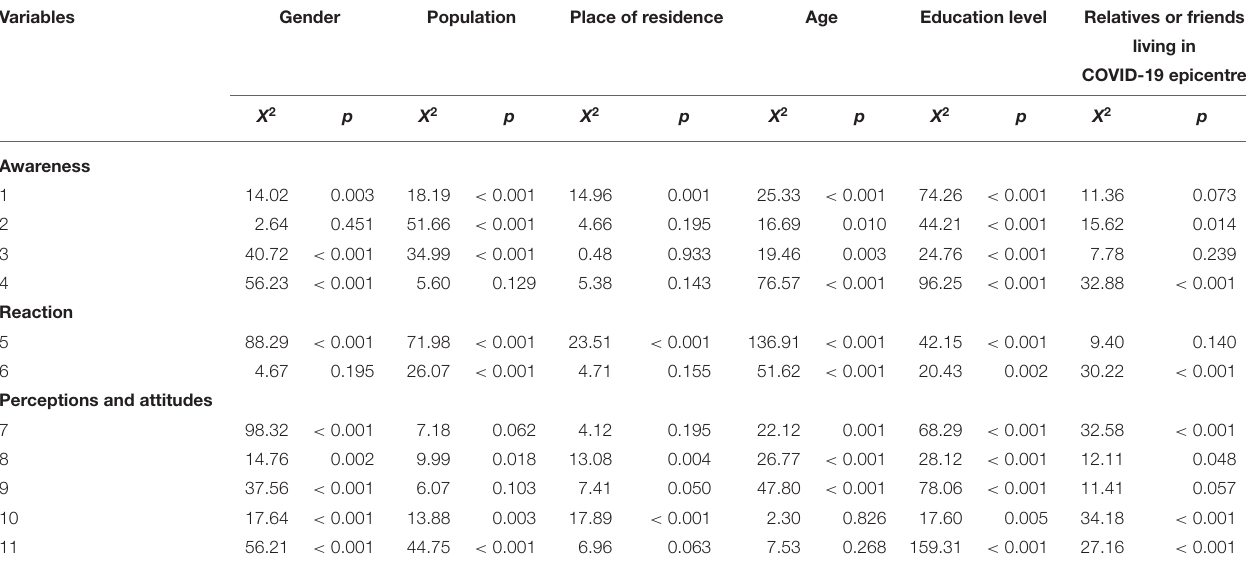
TABLE 2 | Demographic characteristics of participants ( N = 2,263). Variables